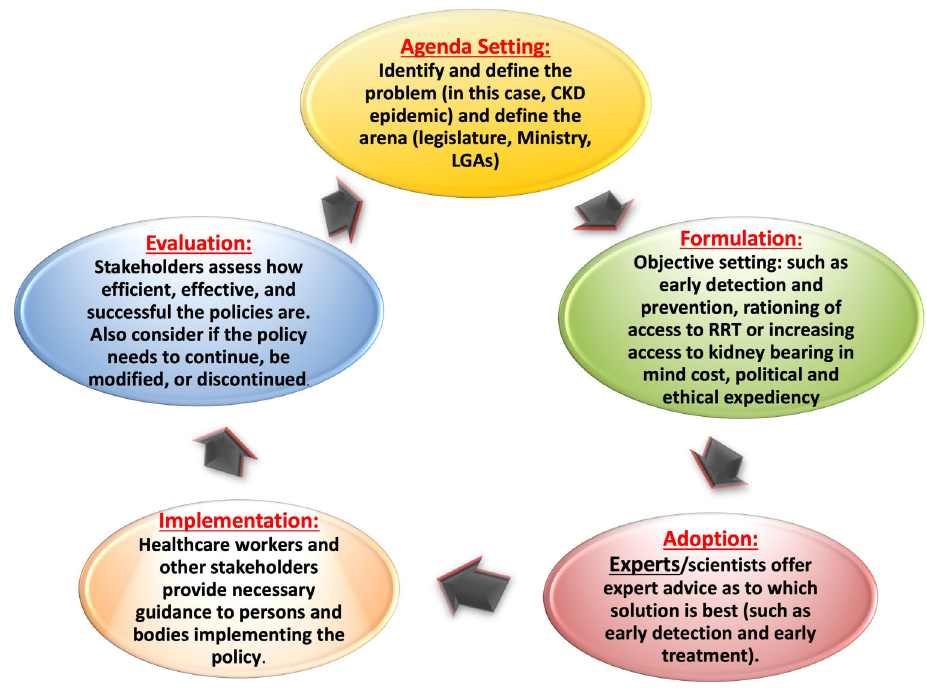
Figure 2. Policy cycle involving 5 stages of policy development. CKD: chronic kidney disease; RRT: renal replacement therapy; LGA: local government